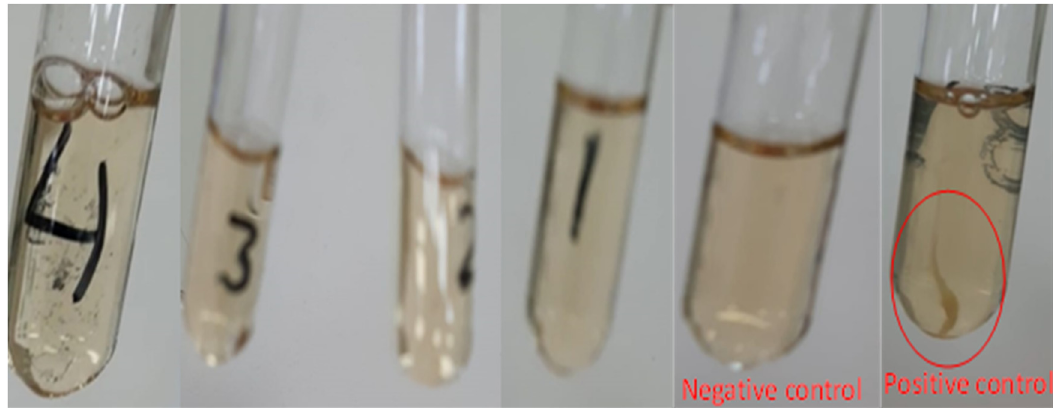
Figure 7: Microbial penetration study.